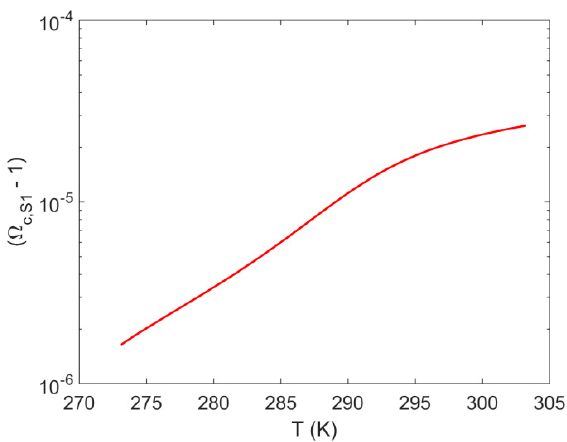
−Ω 1 Figure 5. Plotting the term )( as a function of temperature along the three-phase (H–L w – Figure 5. Plotting the term ( Ω c , S 1 − 1 ) as a function of temperature along the three-phase (H–L w –V) 1 , Sc equilibrium line of sI methane hydrate for a porous system S1. V) equilibrium line of sI methane hydrate for a porous system S1.